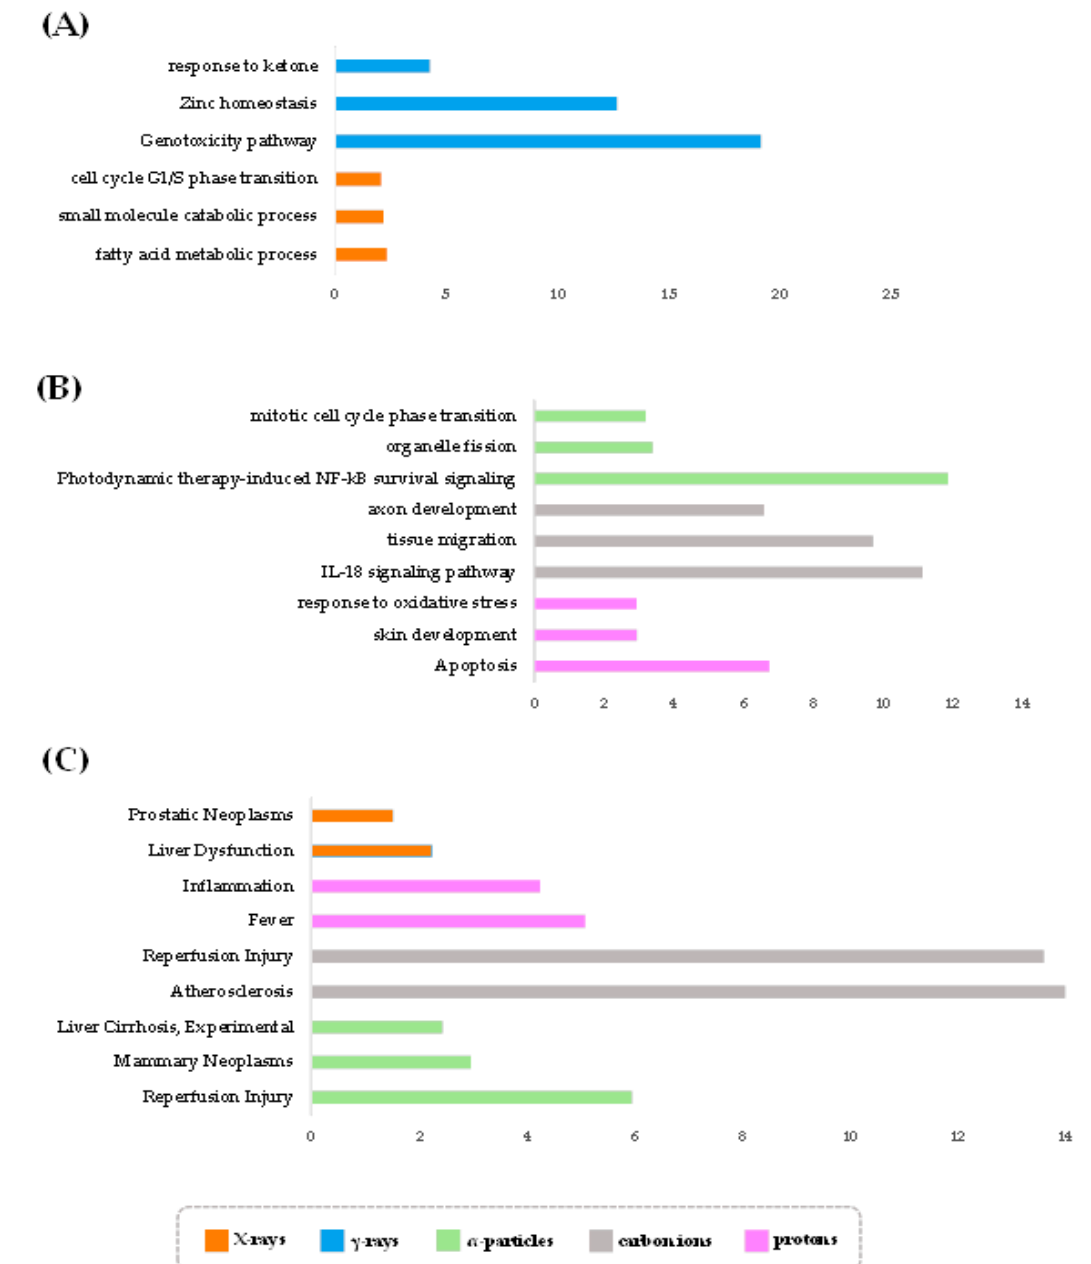
Figure 3. Gene set enrichment analysis. Overrepresented biological pathways (affinity propagation) for the DEGs in different types of radiation. ( A ) Low-LET radiation (X- and γ -rays) and ( B ) higher LET radiation (protons, carbon ions, α -particles). ( C ) Overrepresented disease pathways (affinity propagation) for all DEGs genes in different radiation types. The x -axis corresponds to the enrichment ratio, i.e., the ratio of the number of observed genes to the number of expected genes from each category in the input gene list.